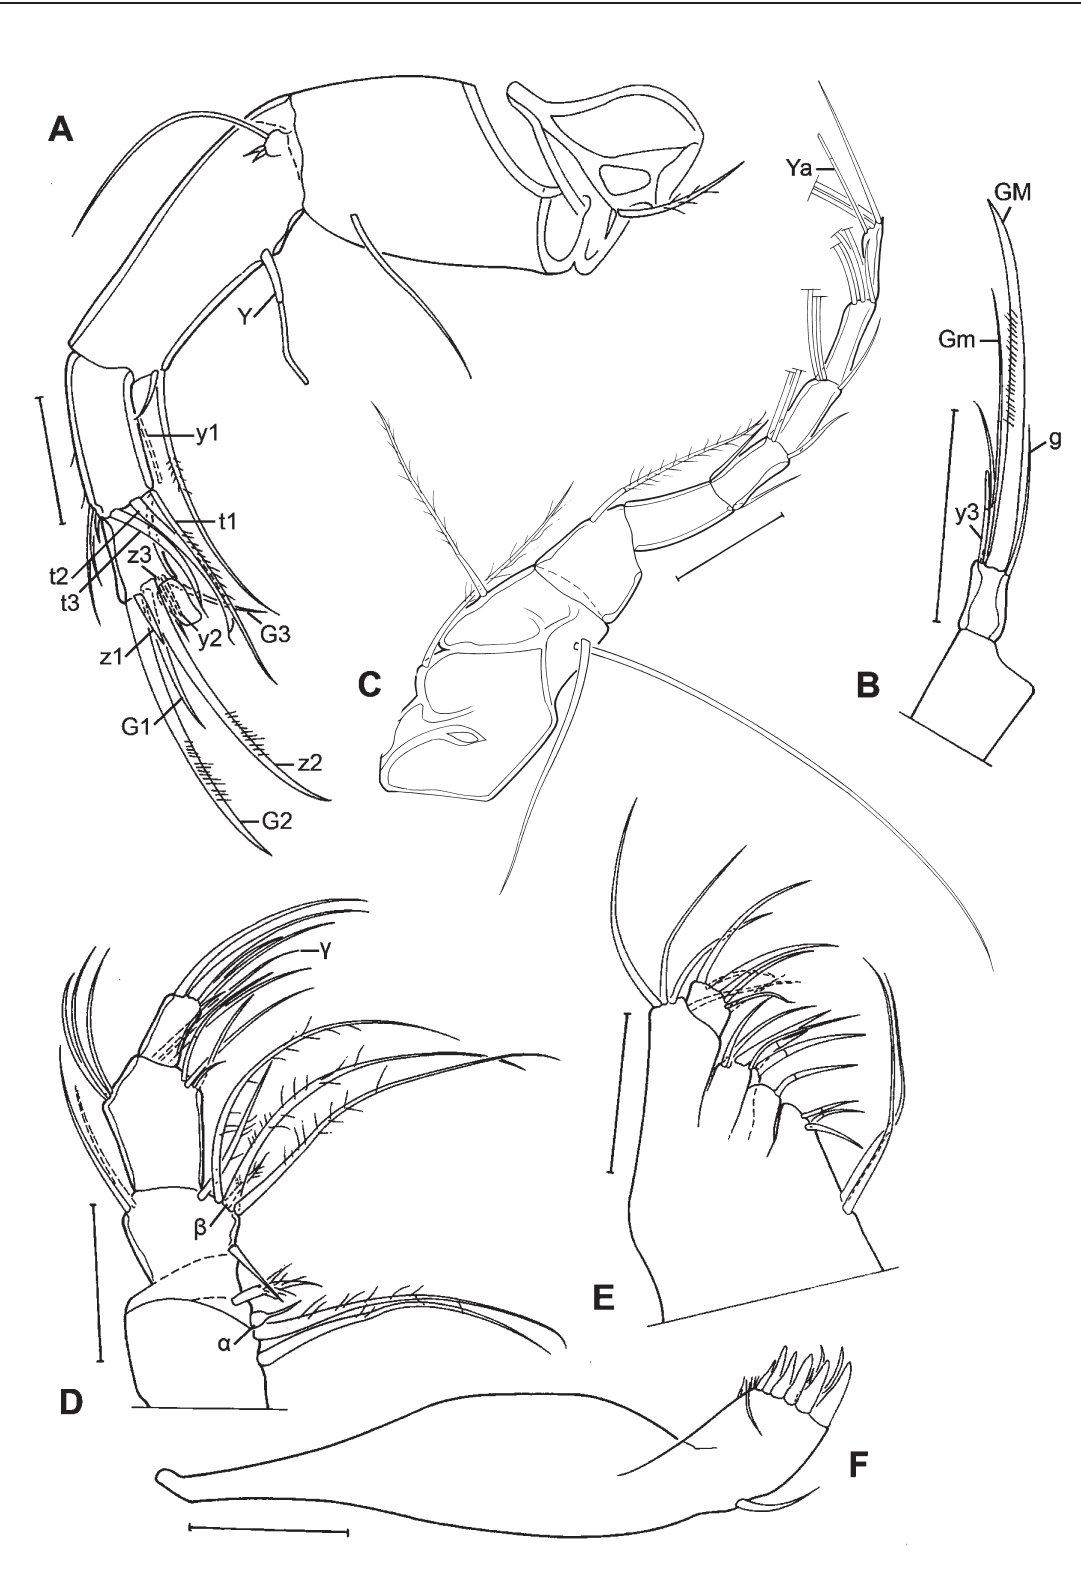
Fig. 9. Candobrasilopsis brasiliensis (Sars, 1901) comb. nov., limbs (♂). A . A2 (MZUSP.28117). B . A2, detail of the last segment (MZUSP.28117). C . A1 (MZUSP.28117). D . Md palp (MZUSP.28117). E . Mx1 (Chaetotaxy incomplete) (OC.3296). F . Md, coxal plate (MZUSP.28117). Scale bars: A-F = 50